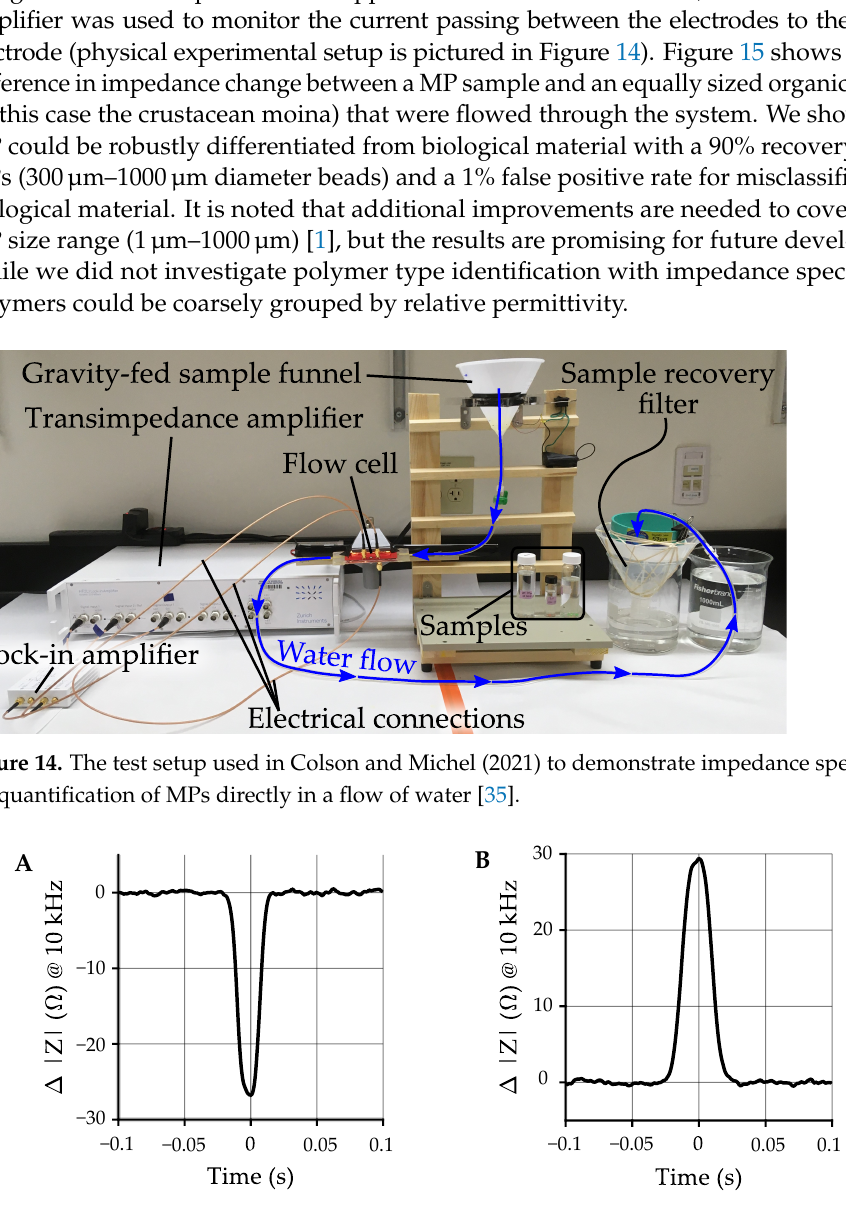
Figure 15. A comparison of impedance time series showing detections ( A ) a moina crustacean (570µm–780µm) and ( B ) PE bead (600µm–710µm). The direction of the impedance change for